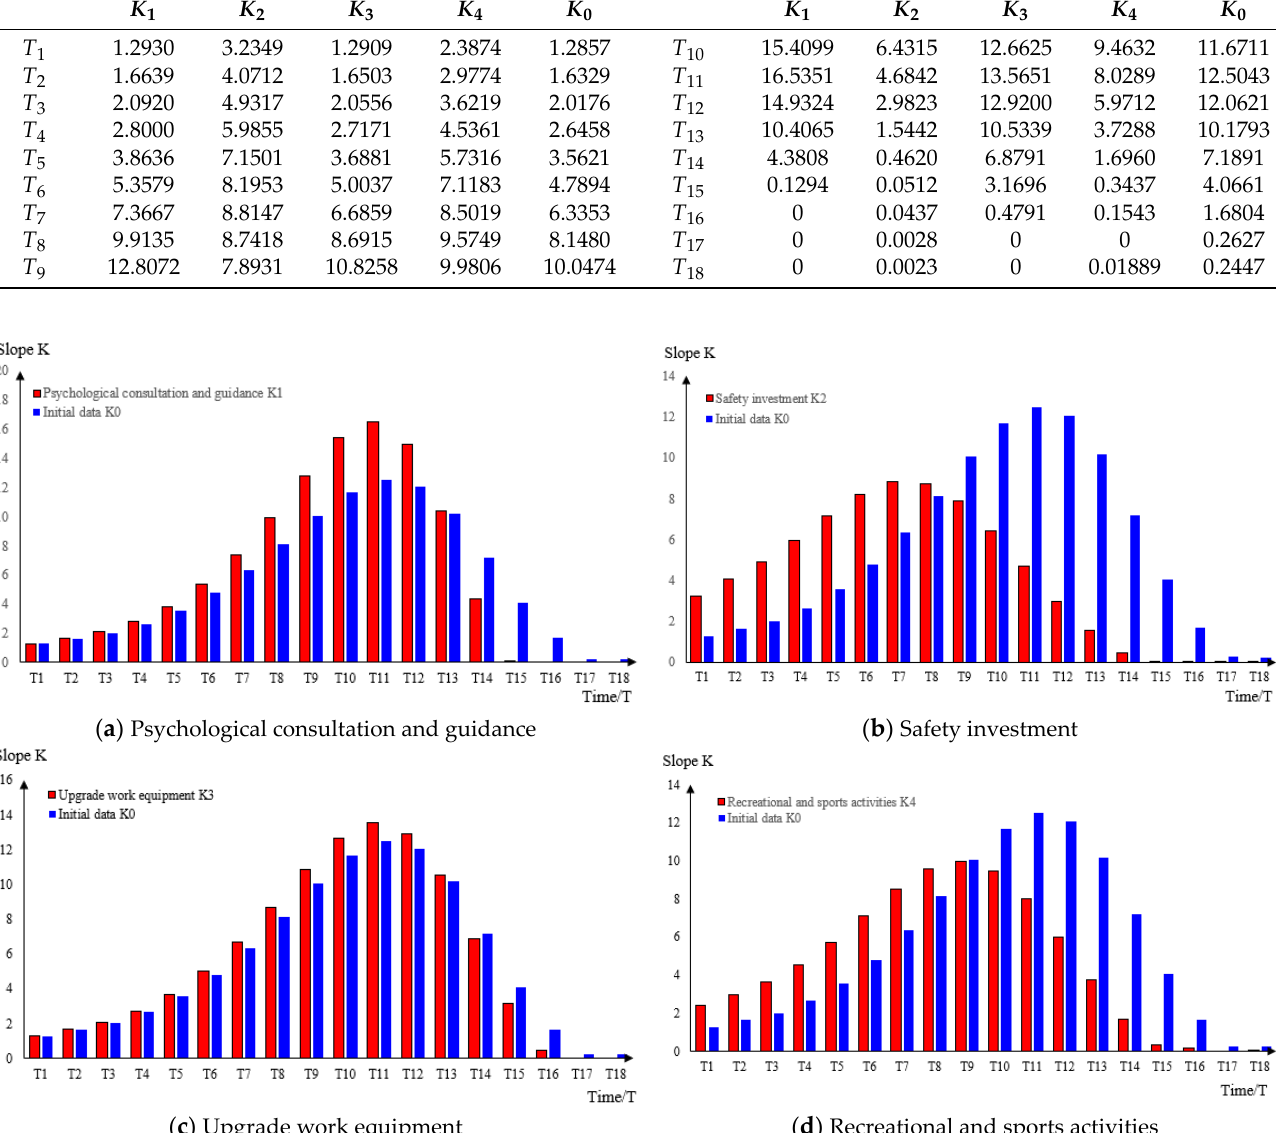
( d ) Recreational and sports activities activities od of time. Figure 4. The comparison of K n in every peri Figure 4. The comparison of K n in every period of Table 2. The growth rate K with each decision power strengthened of EAP system.